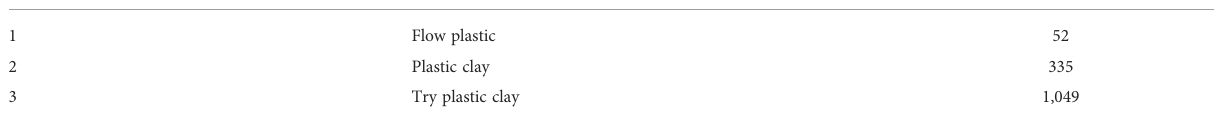
TABLE 4 Results of the penetration